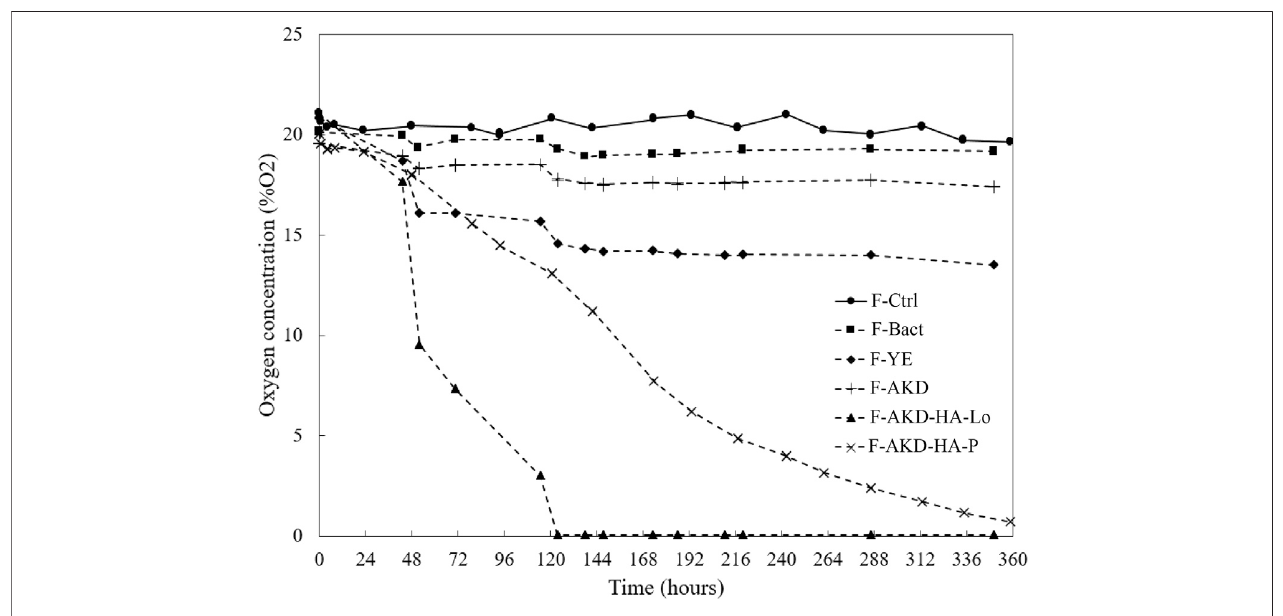
FIGURE 9 | Results of non-invasive oxygen consumption test.